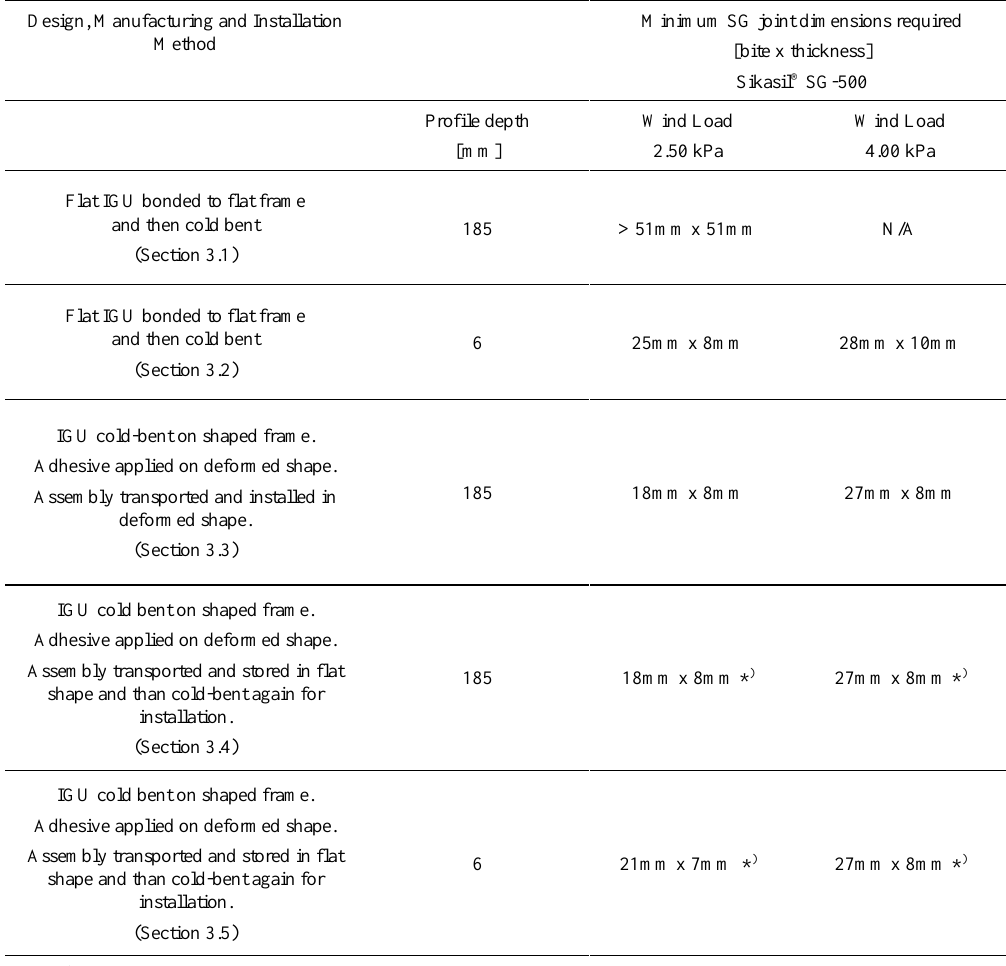
Table 3: Min. SG joint dimensions required for Cold-Bent System, considering all loads occurring during service life based on relevant load combinations (Section 2.3 and